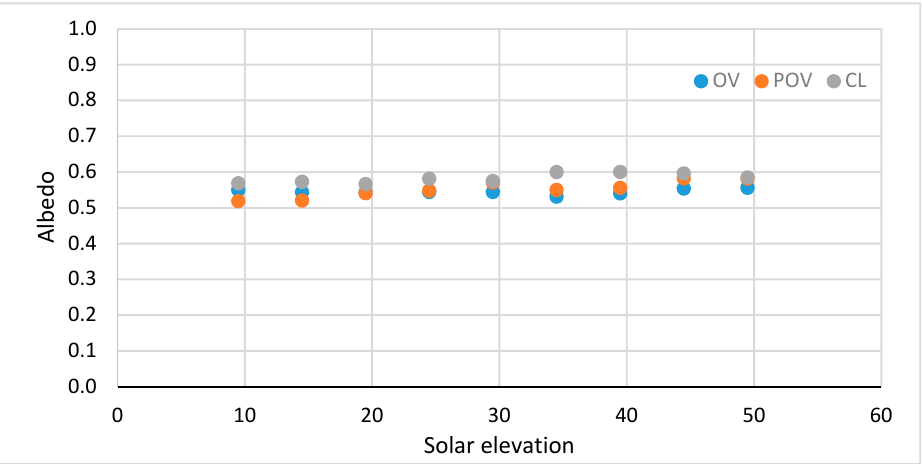
Figure 4. Albedo of white pebbles under varying sky conditions.